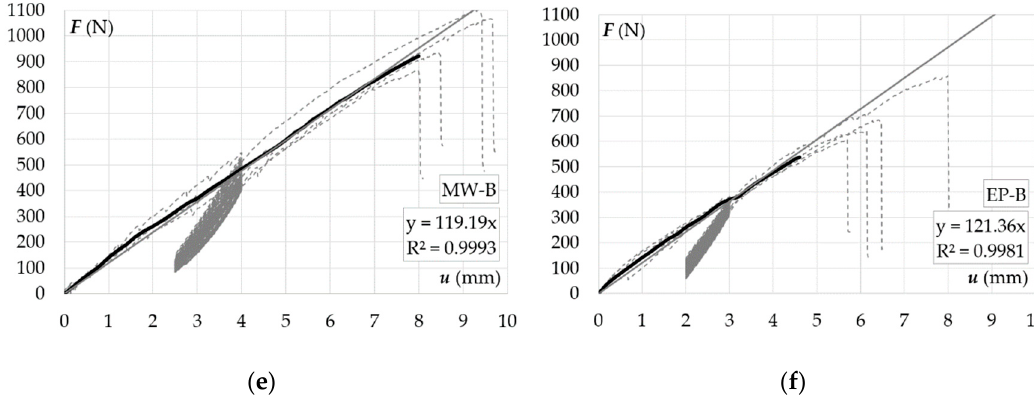
Figure 6. Axial pull-out of a blind rivet from a sandwich panel facing: ( a ) static pull-out from a panel with a PIR foam core, ( b ) static pull-out from a panel with a mineral wool core, ( c ) static pull-out from a panel with expanded polystyrene, ( d ) quasi-cyclic pull-out from a panel with a PIR foam core, ( e ) quasi-cyclic pull-out from a panel with a mineral wool core, ( f ) quasi-cyclic pull-out from a panel with expanded polystyrene.